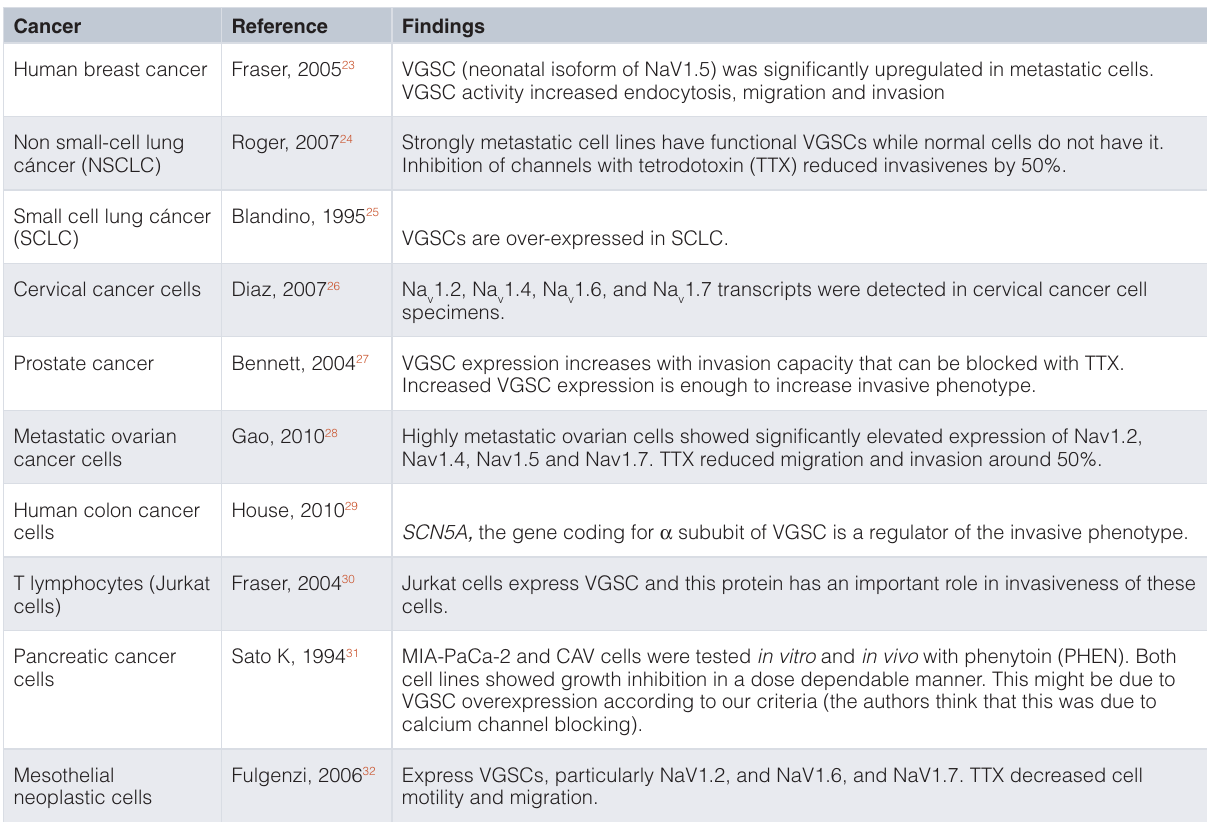
Table 1. VGSC functional over-expression in different cancer tissues.